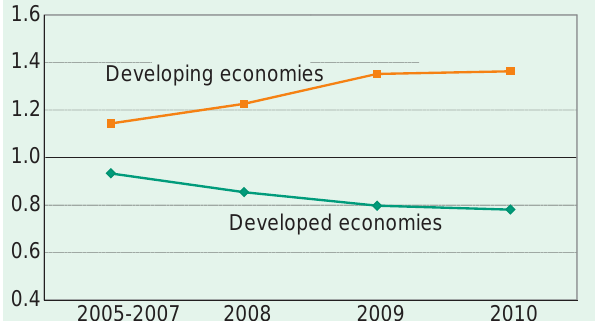
Fig. 2. FDI performance index in developed and developing economies. Source: UNCTAD (2011;